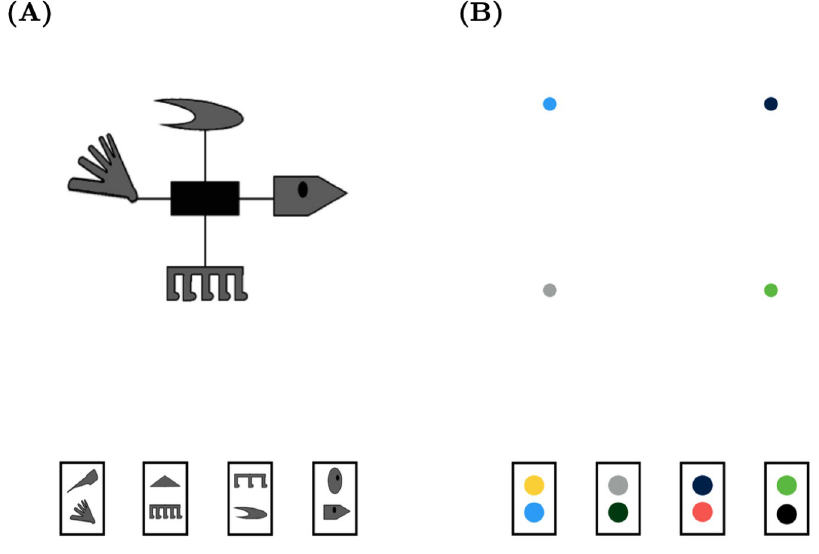
Fig 9. Simulation 2: Model fits to transfer responses. Average categorizations on the 16 transfer stimuli, over all models/subjects. Error bars represent standard error of the mean.